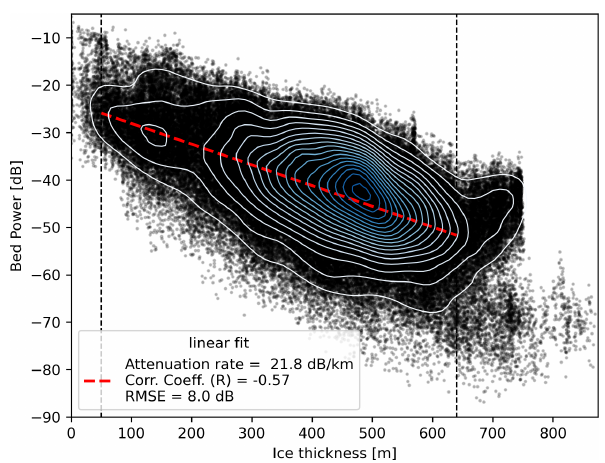
Figure 2. Derivation of englacial attenuation rates. Correlation and linear fit (red) between the ice thickness and the geometrically cor- rected bed power of the SRH1 dataset over DIC, along with contour lines indicating the density distribution. The attenuation rate is de- rived from the slope of the fit (21.8dBkm − 1